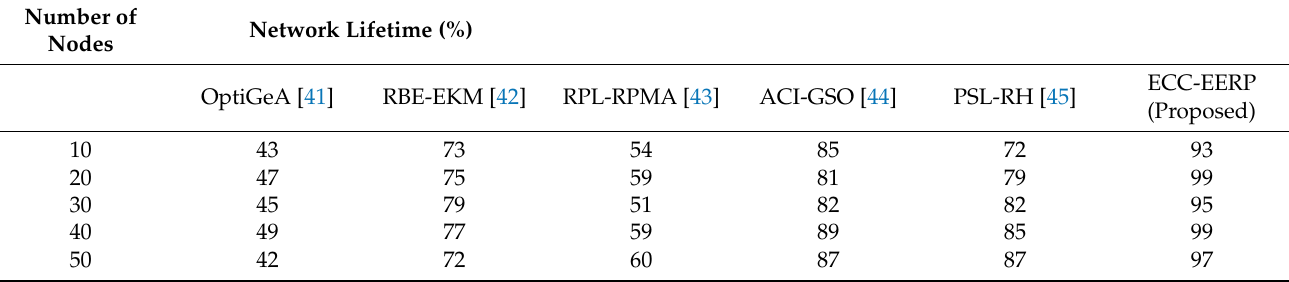
Figure 7. Network lifetime of the proposed and existing techniques [41–45]. Table 6. Network lifetime of the proposed and existing techniques .